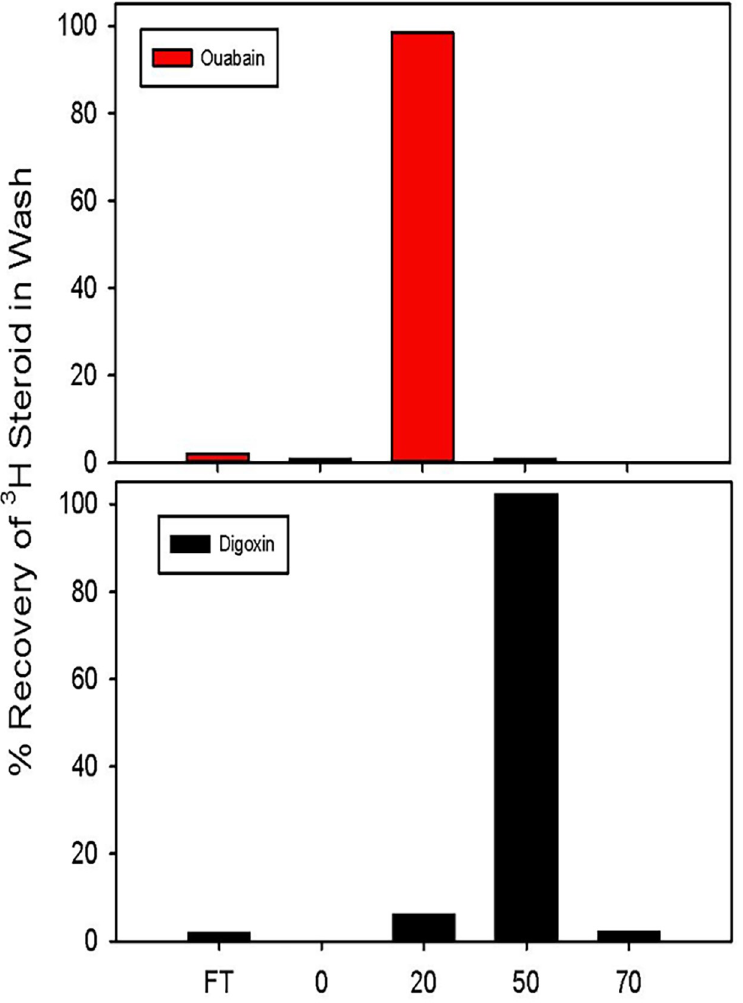
Fig 1. Elusion of ouabain and digoxin. A: Extraction and differential elution of 3 H-ouabain 9upper panel) and 3 H- digoxin (lower panel) from C18 columns. Labelled steroids were introduced into conditioned cell culture medium and applied to preconditioned C18 columns as described. The flow through (FT) as well as the eluates from the 0, 20, 50 and 70% CH 3 CN washes were collected and counted. Results are shown as the average of duplicate